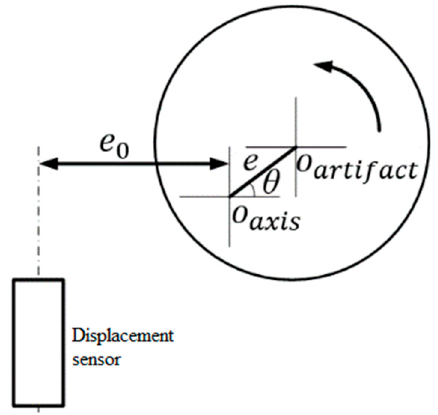
Figure 10. Tangential offset caused by eccentricity error.